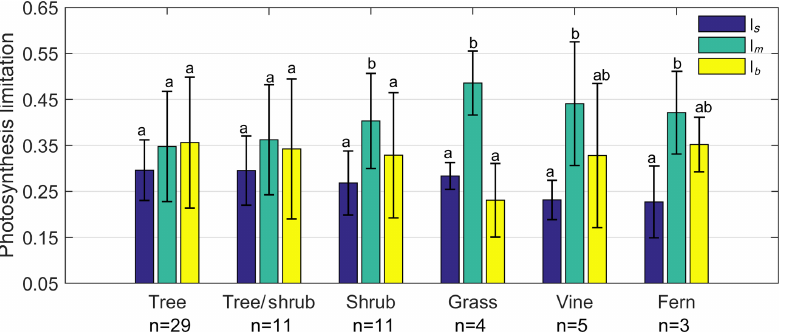
Figure 5. Limitation to light-saturated net photosynthesis ( A ) in six life forms by stomatal conductance to CO 2 ( l s ) , mesophyll conductance to CO 2 ( l m ) , and the maximum carboxylase activity of Rubisco ( l b ) . Error bars denominate standard deviation (1 σ ).